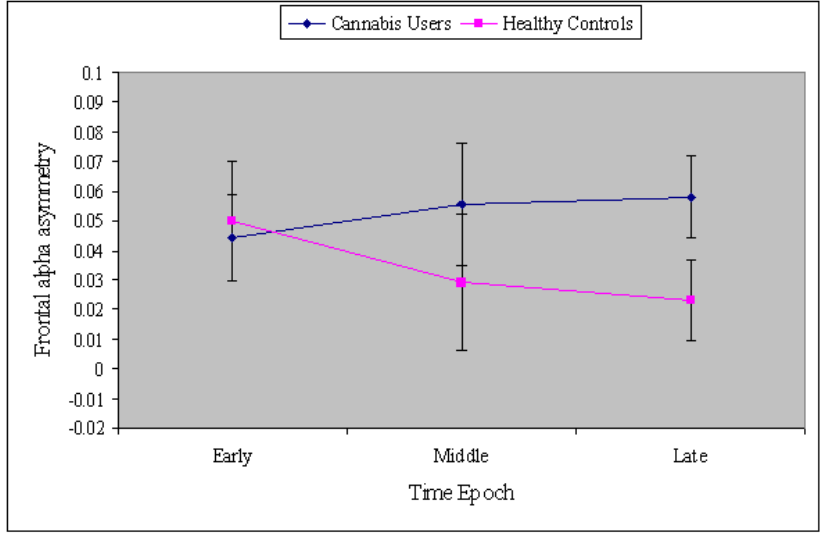
Figure 4. Group difference (cannabis users vs. controls) in FAA. The largest group difference was during the middle and late time epochs. Error bars represent the standard error of the mean. See the online article for the color version of this figure.